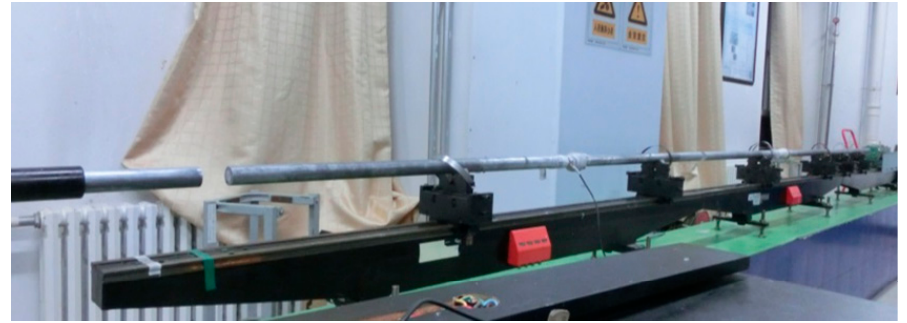
Figure 4. The compressive split-Hopkinson pressure bar (SHPB) system.